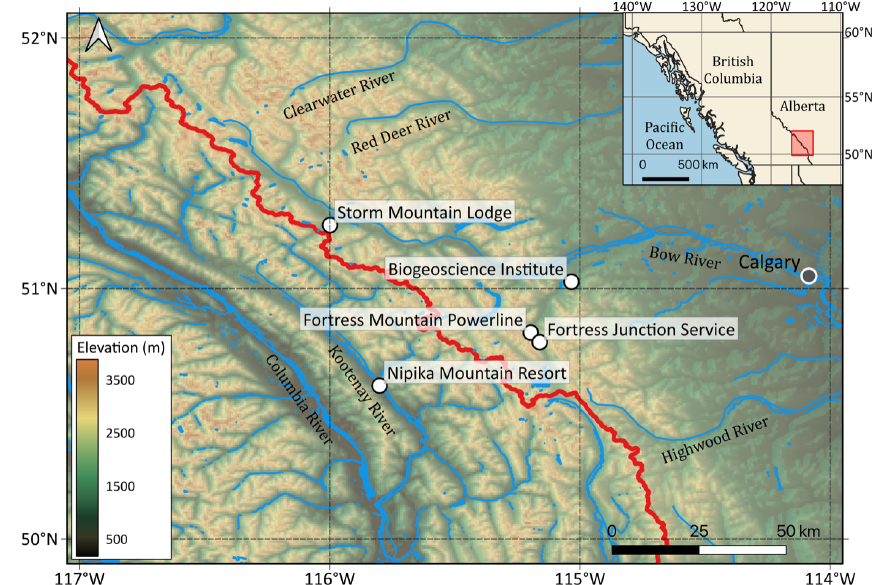
Figure 1. Map of the SPADE field campaign domain in British Columbia and Alberta with the location of the field sites (white dots), which are Nipika Mountain Resort (NMR), Storm Mountain Lodge (SML), Fortress Mountain Powerline (FMP), Fortress Junction Service (FJS), the University of Calgary Biogeoscience Institute (BGI), the major city of Calgary (grey dot), and the continental divide (red line). Local rivers are shown in blue and labelled. The inset map shows the SPADE field campaign area (red outline) in relation to western